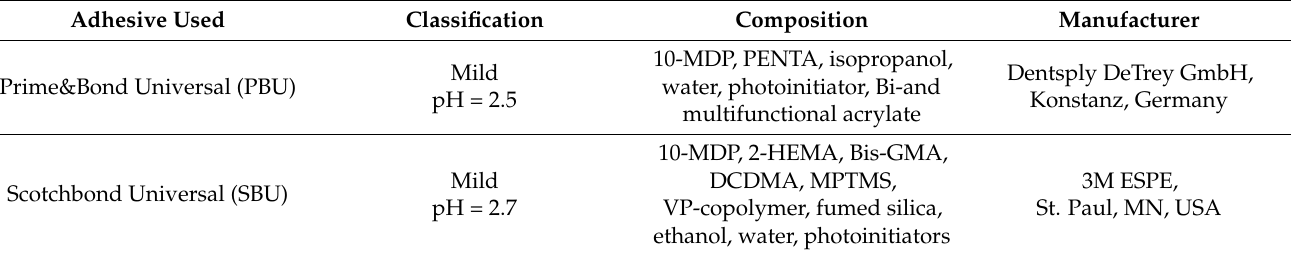
Table 1. Manufacturer and composition of the universal adhesives used.